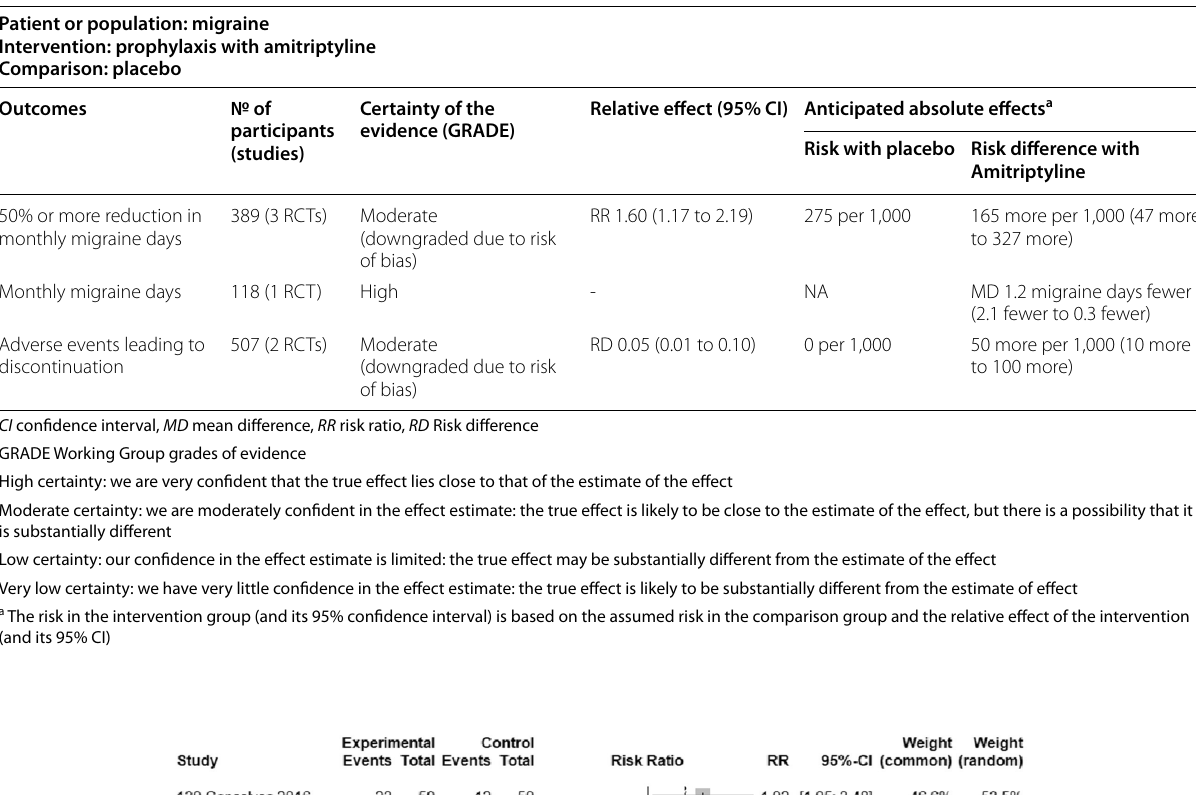
Table 2 Amitriptyline compared to placebo for migraine prophylaxis